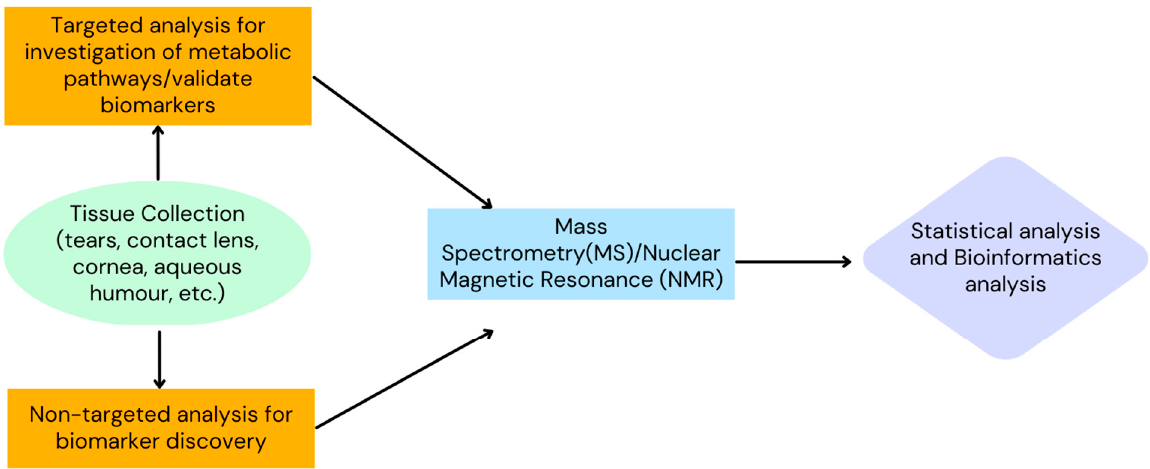
Figure 2. Flowchart depicting the methodology of corneal metabolomics.